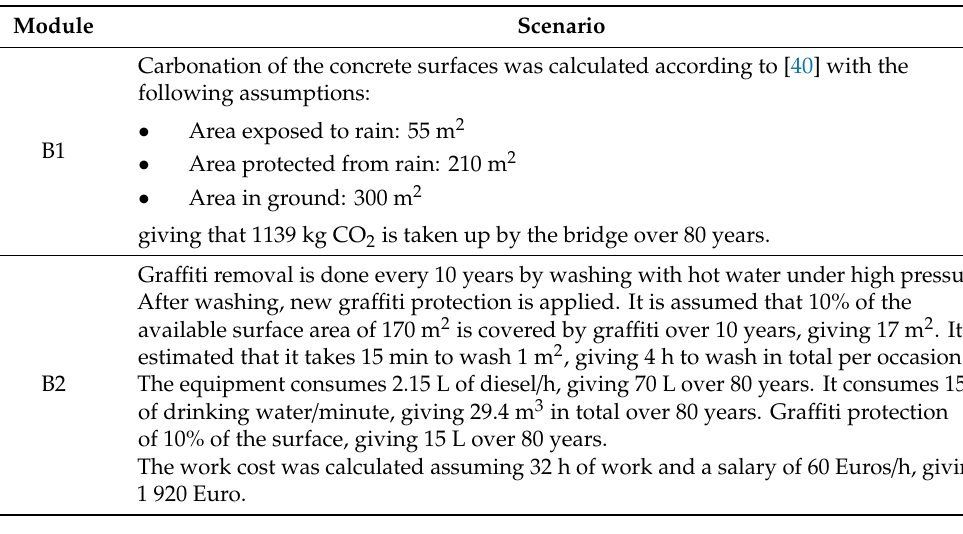
Figure A1. Estimated mean daily traffic on the bridge per year over the RSL (up to 80 years after construction). Table A4. Specific scenarios for the CSF bridge design concept for each module (B–D).